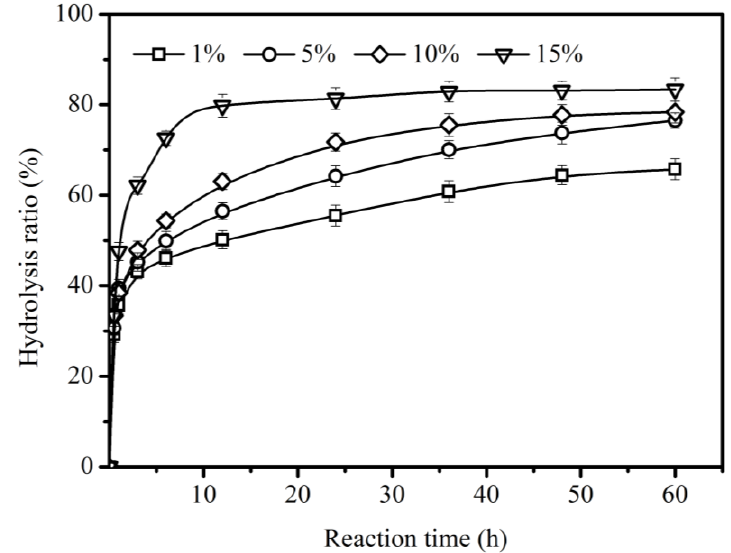
Figure 4. Effect of enzyme load (relative to the weight of all substrates) on the hydrolysis of CO using Lipozyme TLIM. Reaction conditions: 0.031 mol CO in the presence of 5.51 mL water, at 40 °C, and at 200 rpm.